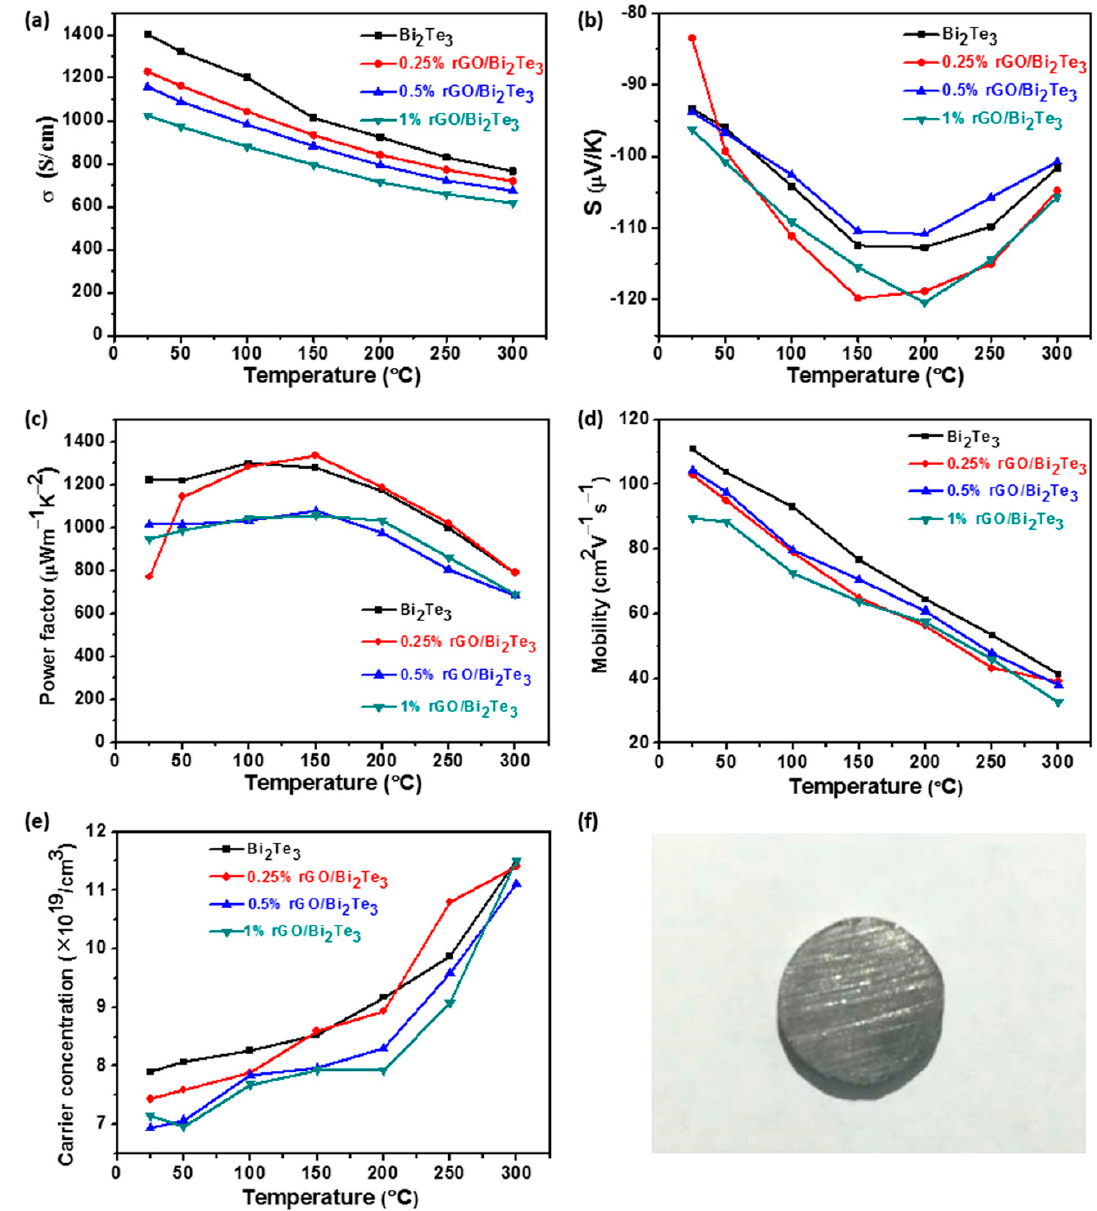
Figure 7. Temperature dependent ( a ) electrical conductivity; ( b ) Seebeck coefficient; ( c ) power factor; ( d ) carrier mobility; and ( e ) carrier concentration of rGO / Bi 2 Te 3 nanocomposite bulk materials with di ff erent contents of rGO from 0 to 1 wt%; ( f ) Digital photo of rGO / Bi 2 Te 3 nanocomposite bulk materials with 1 wt% rGO.